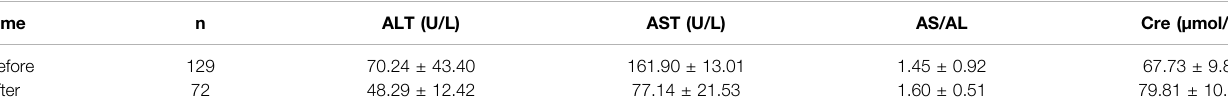
TABLE 2 | Liver and kidney function of cancer patients with tigecycline treatment. Time n ALT (U/L) AST (U/L) AS/AL Cre ( μ mol/L) Before